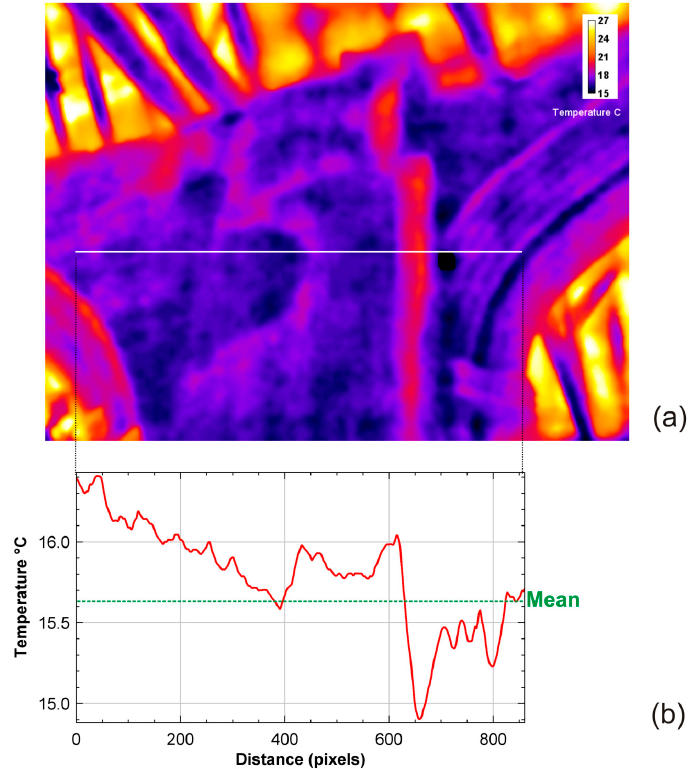
Figure 6. Holme-by-Newark church, Nottinghamshire, U.K. ( a ) thermal infrared image with linear plot line; ( b ) plot of temperature variation from the mean background.